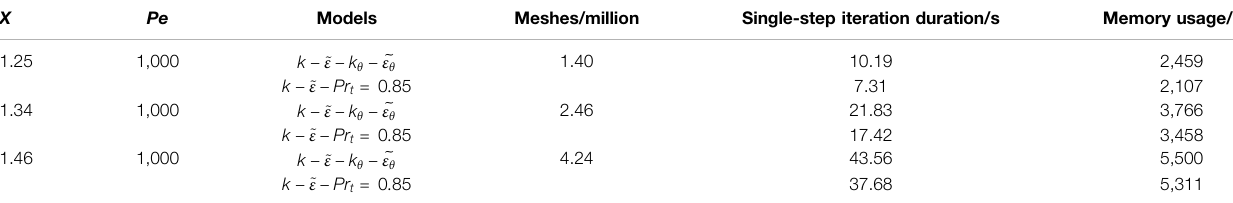
TABLE 7 | Performance of the four-equation model under serial operation. Pe